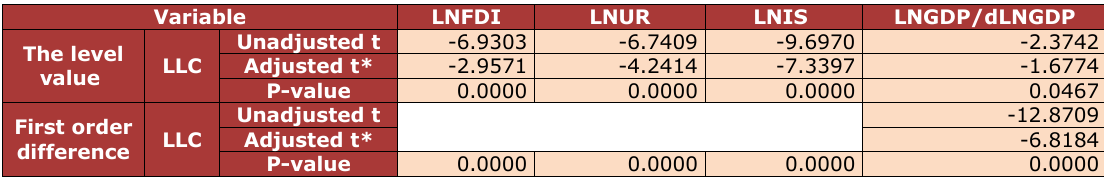
Table 3. Results of panel unit root test of Guangdong province